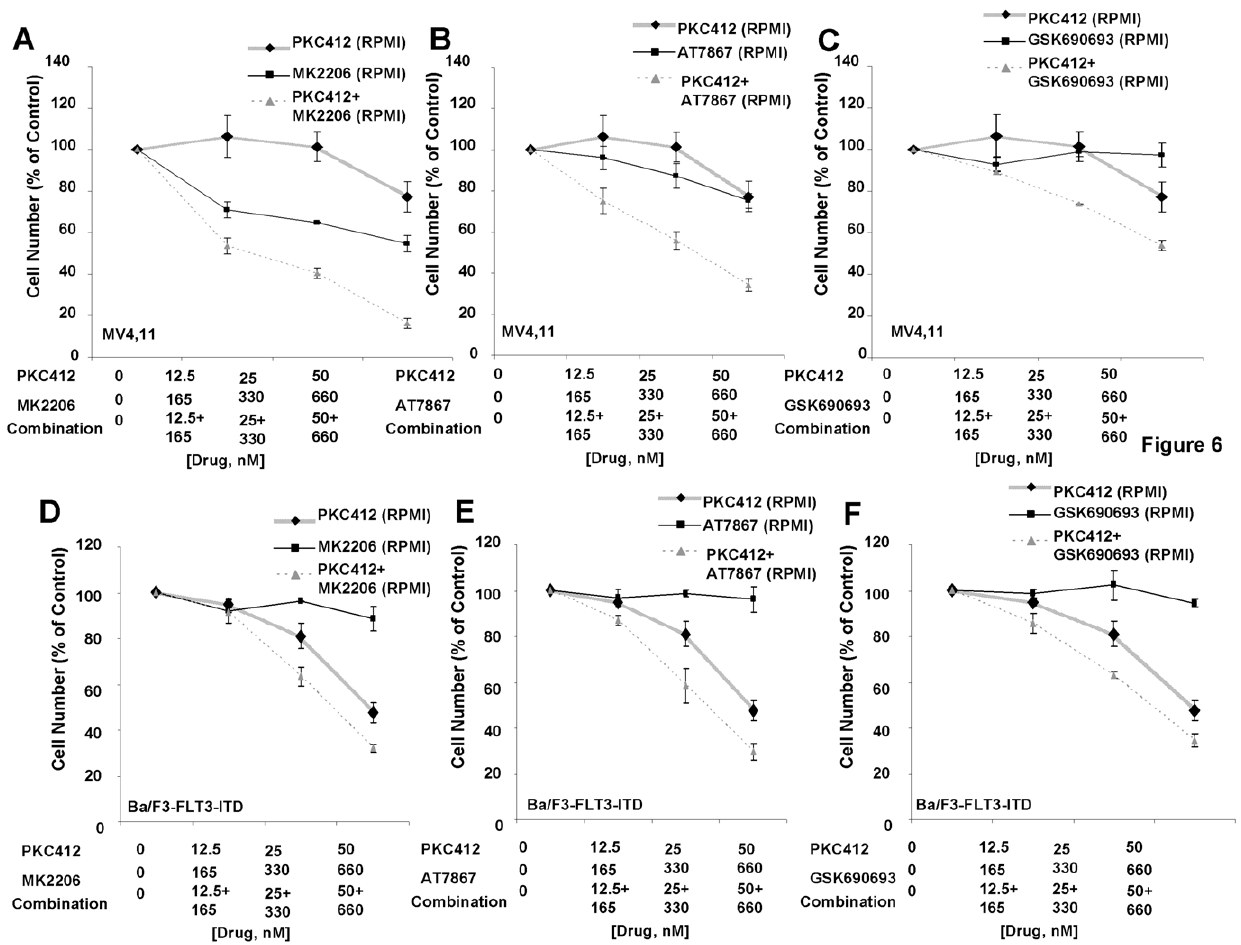
Figure 6. Selective inhibitors of AKT positively combine with PKC412 in RPMI + 10% FBS against MV4,11 and Ba/F3-FLT3-ITD cells. (A–C) Approximately two-day proliferation studies performed with selective AKT inhibitors in combination with PKC412 in RPMI + 10% FBS against MV4,11 cells. (D–F) Approximately two-day proliferation studies performed with selective AKT inhibitors in combination with PKC412 in RPMI + 10% FBS against Ba/F3-FLT3-ITD cells.